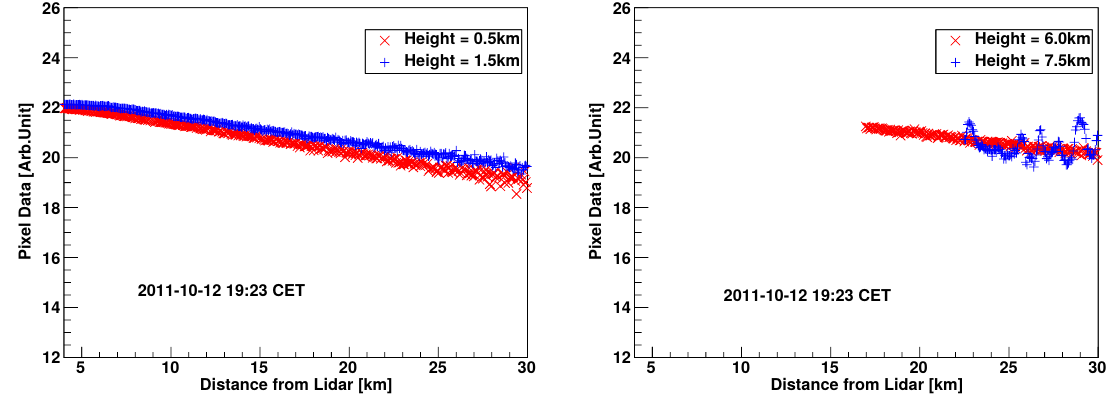
Figure 5. Examples of the horizontal pixel data extracted from the 2D RHI diagrams (Figure 4). ( Left ) At the heights of 0 . 5 km and 1 . 5 km ; ( Right ) at the heights of 6 . 0 km and 7 . 5 km . Height is given relative to the altitude of the LiDAR